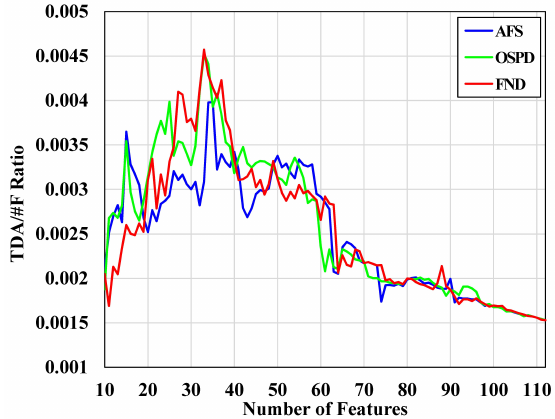
Figure 13. The ratio of target detection accuracy (TDA) to the number of features (#F) for the AFS, OSPD and FND methods. Detection was conducted by CEM using the HyMap dataset.